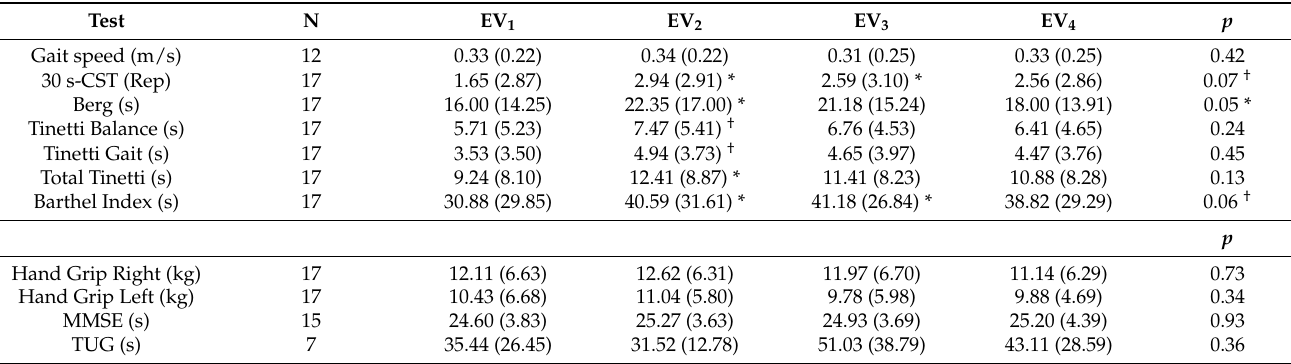
Table 2. Quantitative changes (mean and standard deviation) in physical and mental status: The Friedman and Wilcoxon test (upper section); ANOVA repeated measures test (lower